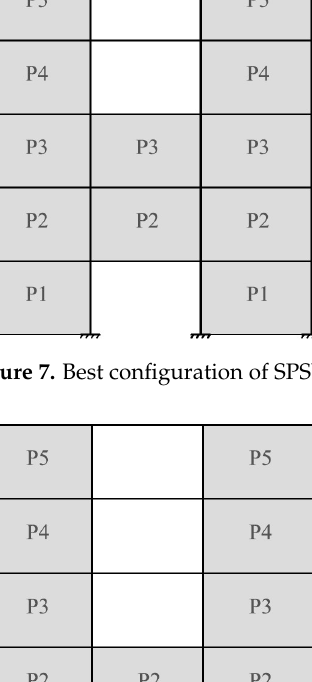
Figure 8. Best configuration of SPSW3-5-SGA.